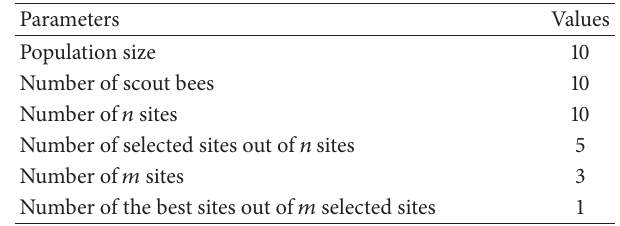
Table 1: Parametric values used for adaptive ABC.